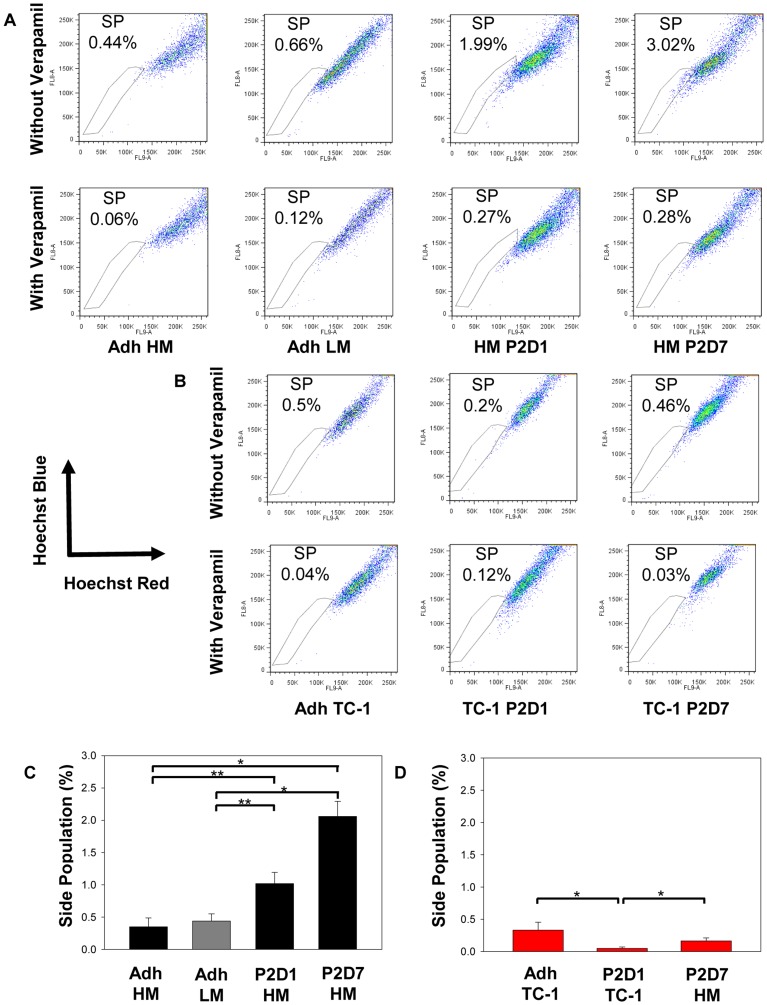
Hoechst 33342 side population (SP) expression is enhanced in HM-LLC but not in TC-1 spheres compared to adherent cells.Representative SP plots for (A) LLC cells and (B) TC-1 cells comparing matched adherent cells to passage 2, day 1 and day 7 sphere-derived cells. Hoechst 33342 staining was confirmed with verapamil blockade. (C) SP frequency was significantly increased in HM-LLC spheres compared to adherent cells; *P<0.001; **P≤0.012. HM-LLC and LM-LLC adherent cells were not significantly different for SP frequency. (D) SP was not found to be upregulated in sphere-derived TC-1 cells compared to matched adherent cells. Day 1 sphere-derived cells had a significantly lower frequency of SP cells compared to adherent cells and day 7 sphere-derived cells; *P = 0.03. Plots represent combined data from three biological replicates with three technical replicates each. Bars: ±SEM.